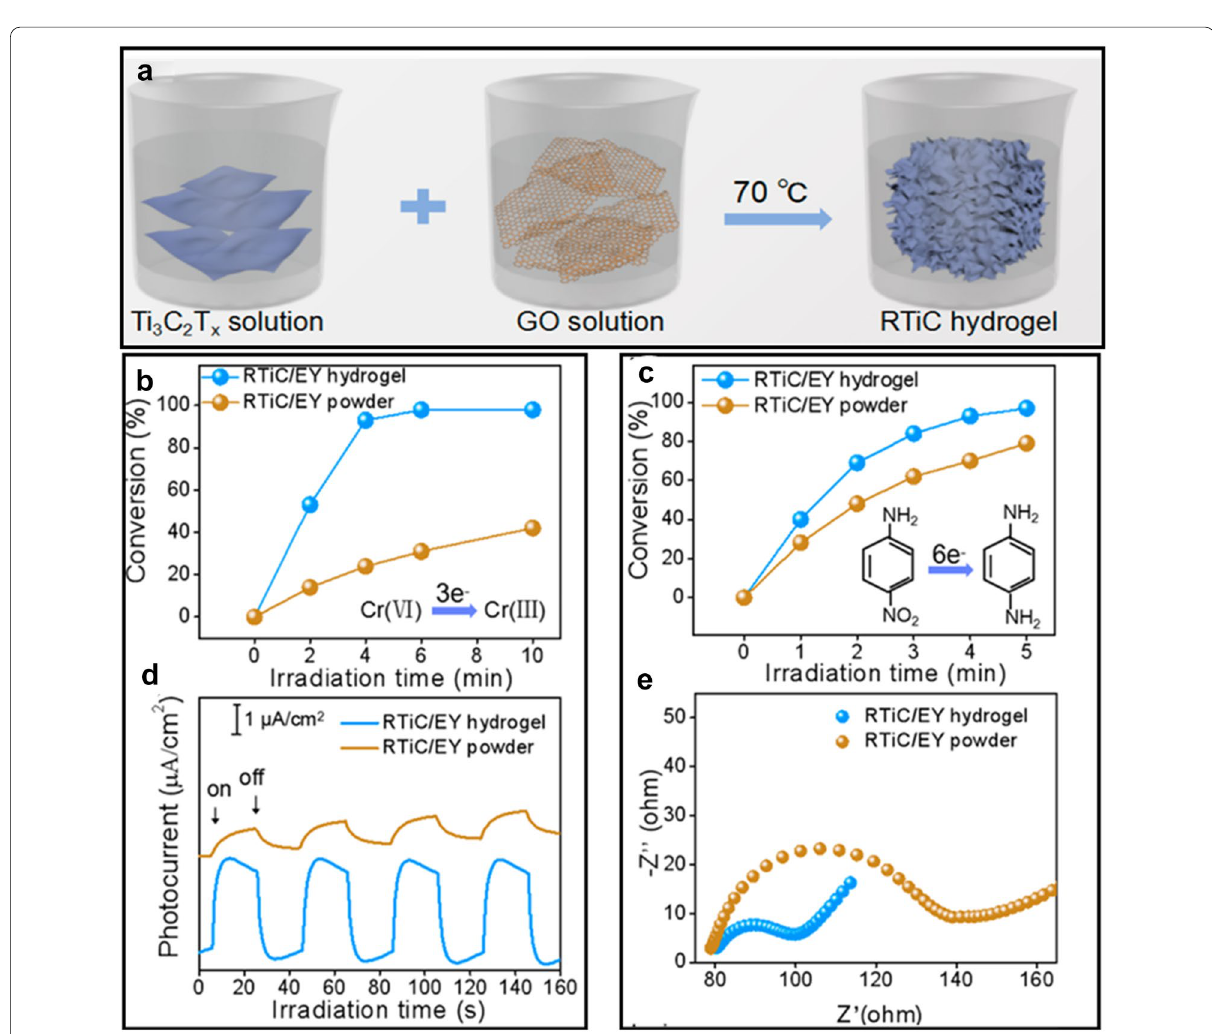
Fig. 6 a Fabrication process of the RTiC with photocatalytic reduction of b Cr(VI) and c 4-NA using RTiC/EY hydrogel and the powdered counterpart with d corresponding transient photocurrent spectra and e Nyquist plots from the electrochemical impedance spectroscopy.